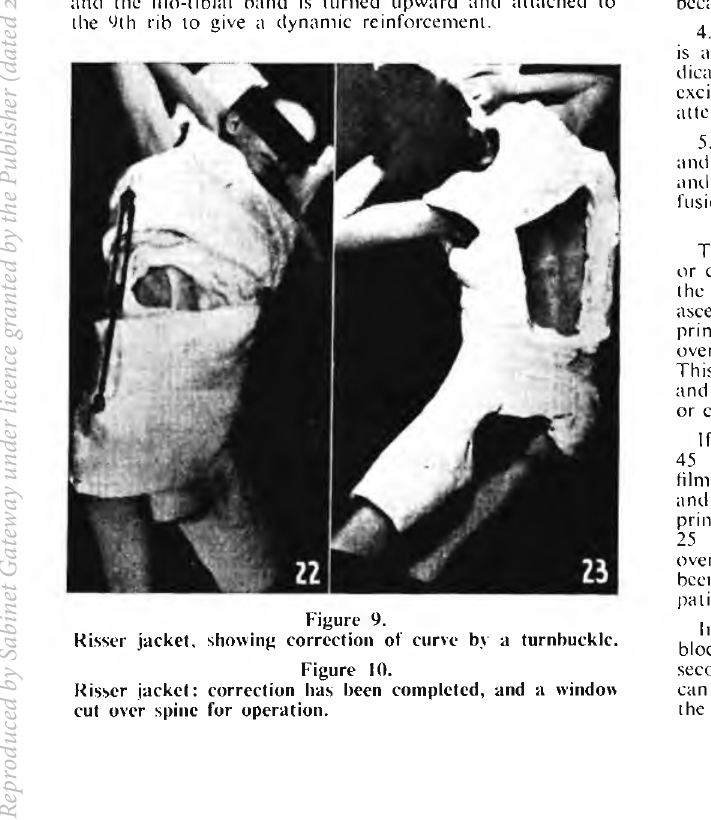
Spinal fusion, showing wide de­ cortication of the laminae, tipping off of the apophyses of the trans­ verse processes, and removal of all soft tissue between the pro­ cesses.